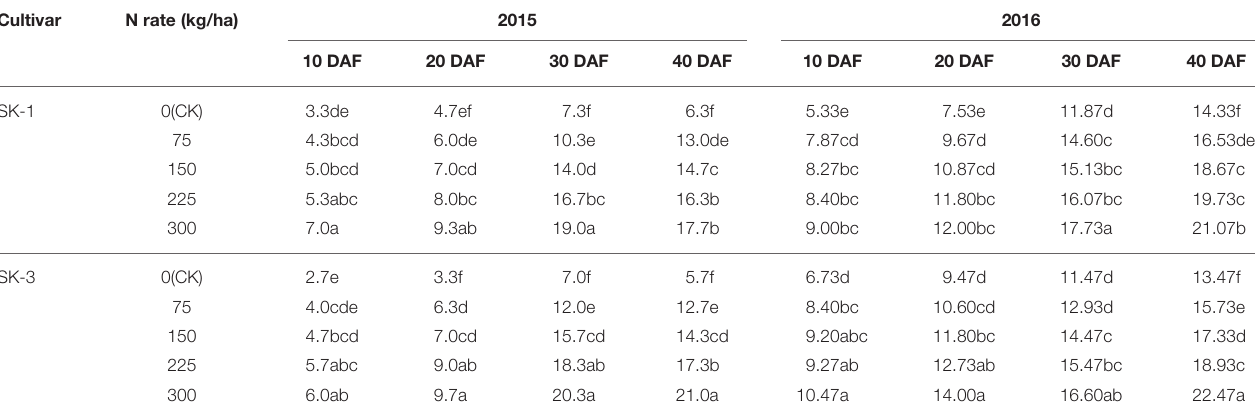
TABLE 1 | The effect of the nitrogen level on the boll number per plant of the two Bt cotton cultivars in 2015 and 2016. Cultivar N rate